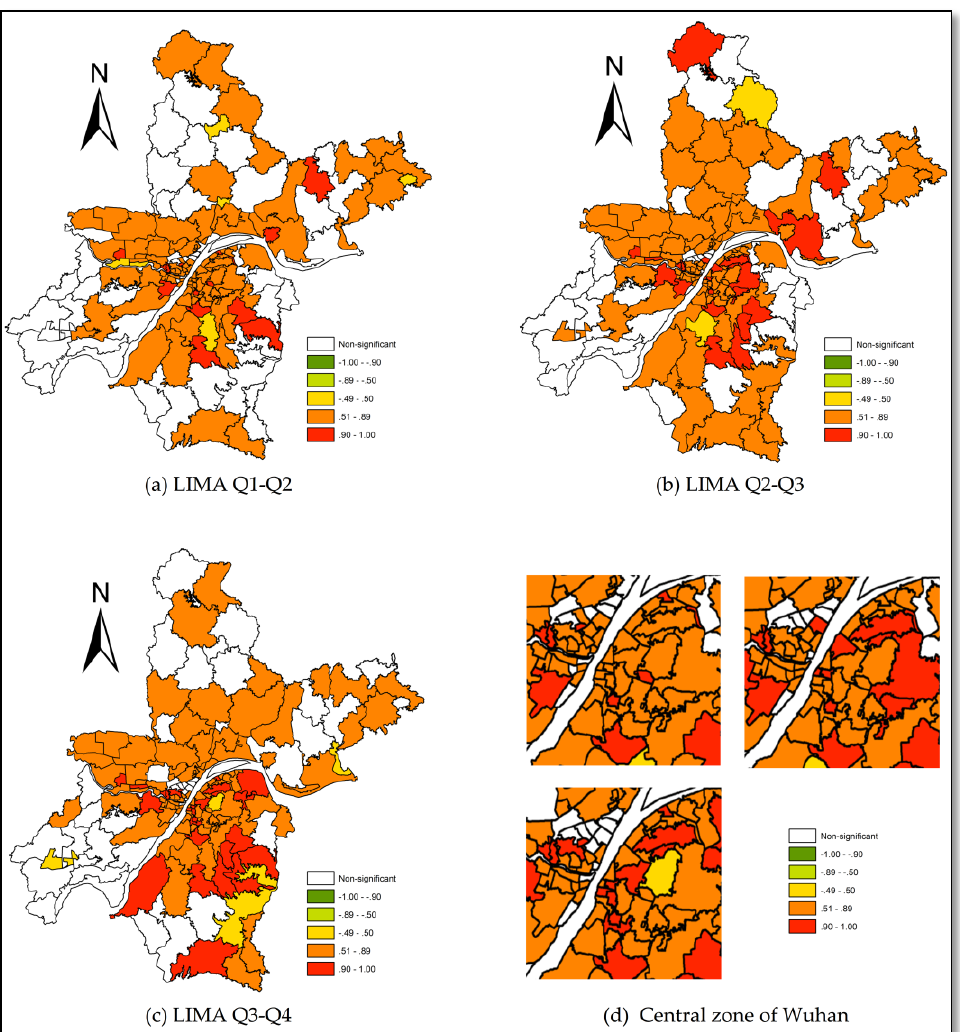
Figure 6. Local Indicator of Mobility Association (LIMA) values in quarters 1–4. Table 2. Global theft rate rank of Caidian Community and adjoining communities. Time Caidian